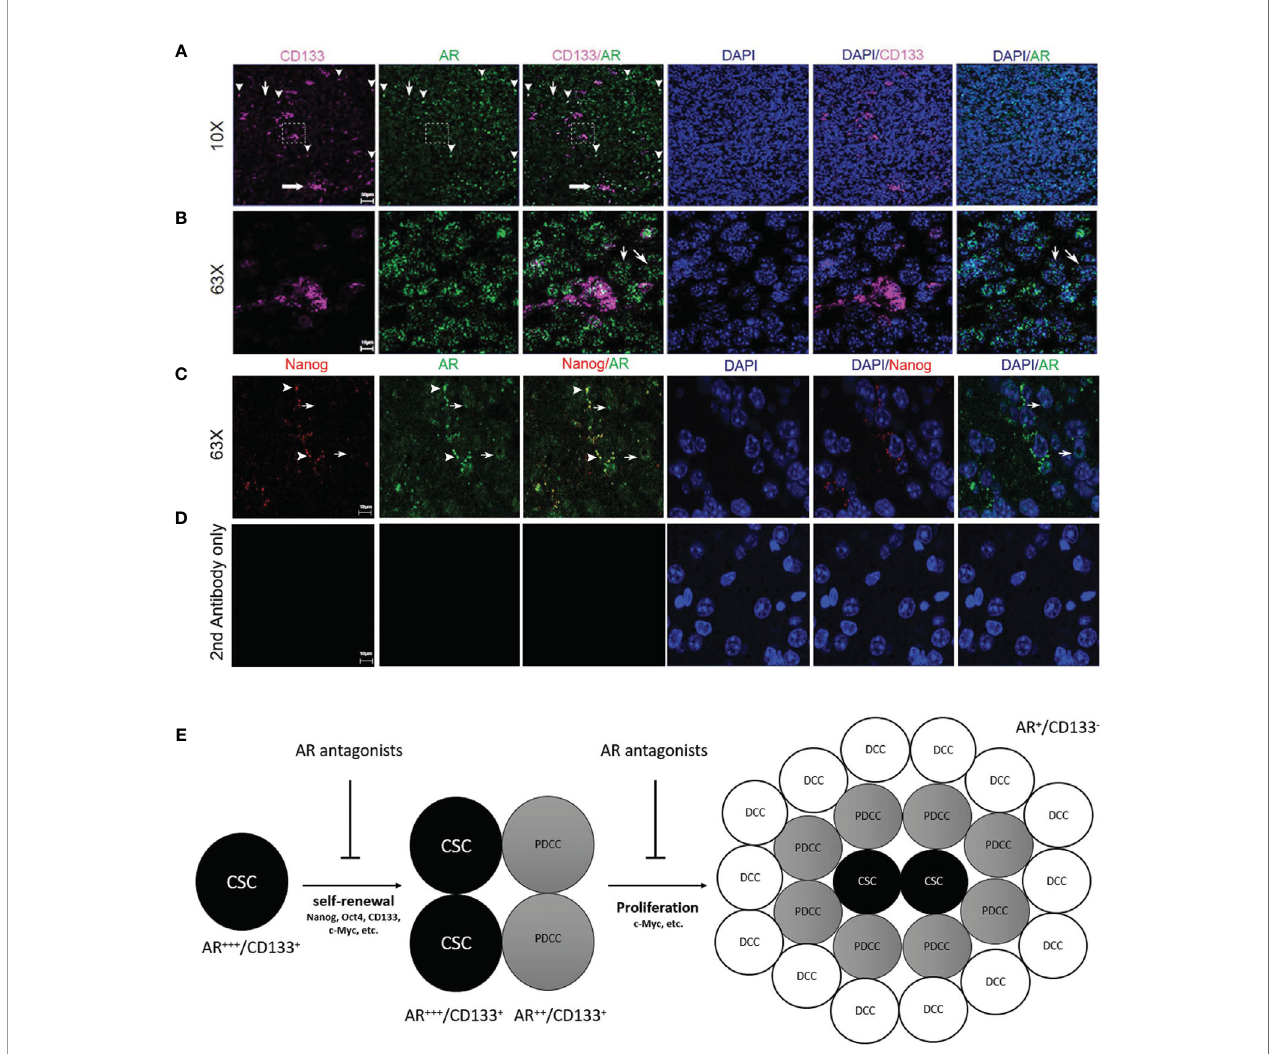
FIGURE 7 | Immuno fl uorescence confocal microscopy on mouse GBM FFPE specimen (5 µm thickness) showing the subcellular localizations of AR (green), CD133 (pink) and DAPI-stained nuclei (blue). (A) Low magni fi cation images (10×) and (B) high magni fi cation images (63×) which were scanned from areas in the dash line boxes in (A) demonstrated co-expression of CD133 in AR-expressing (AR+) cells with high staining intensity (arrowheads). AR expression can be seen in CD133 negative cells but with low AR staining intensity (thin arrows). (C) High magni fi cation images (63×) demonstrated co-expression of Nanog in AR+ cells with high AR staining intensity (arrowheads). Cells with negative Nanog staining could be AR+ but showed weaker AR staining intensities than Nanog+ cells (thin arrows). (D) High magni fi cation images (63×) with slides stained with secondary antibodies only as negative controls. (E) Schematic fi gure showing the proposed mechanisms of AR antagonists inhibiting both cancer stem cells maintenance and cancer proliferation from more differentiated cells. CSC, cancer stem cell; PDCC, partially differentiated cancer cell; DCC, differentiated cancer